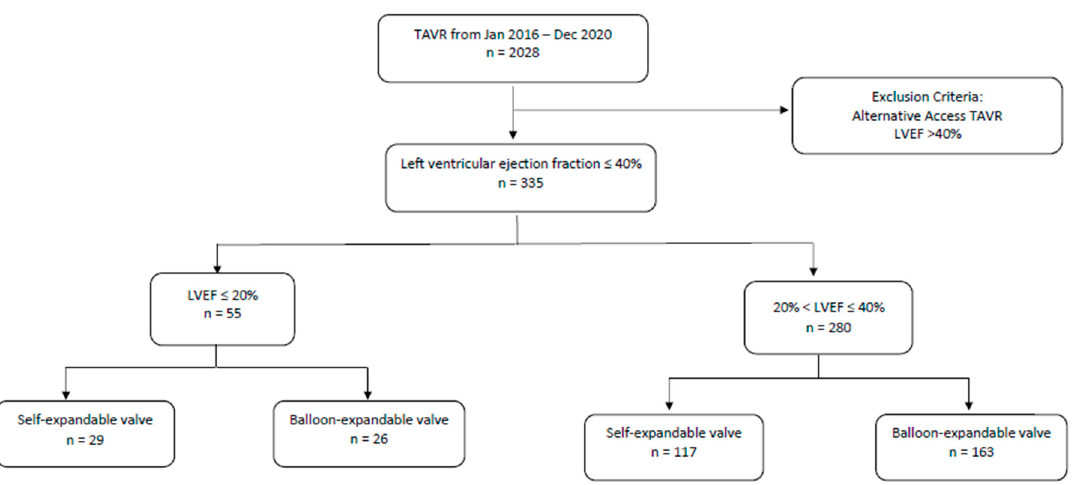
Figure 1. Schematic of study design. LVEF, left ventricular ejection fraction; TAVR, transcatheter aortic valve replacement.